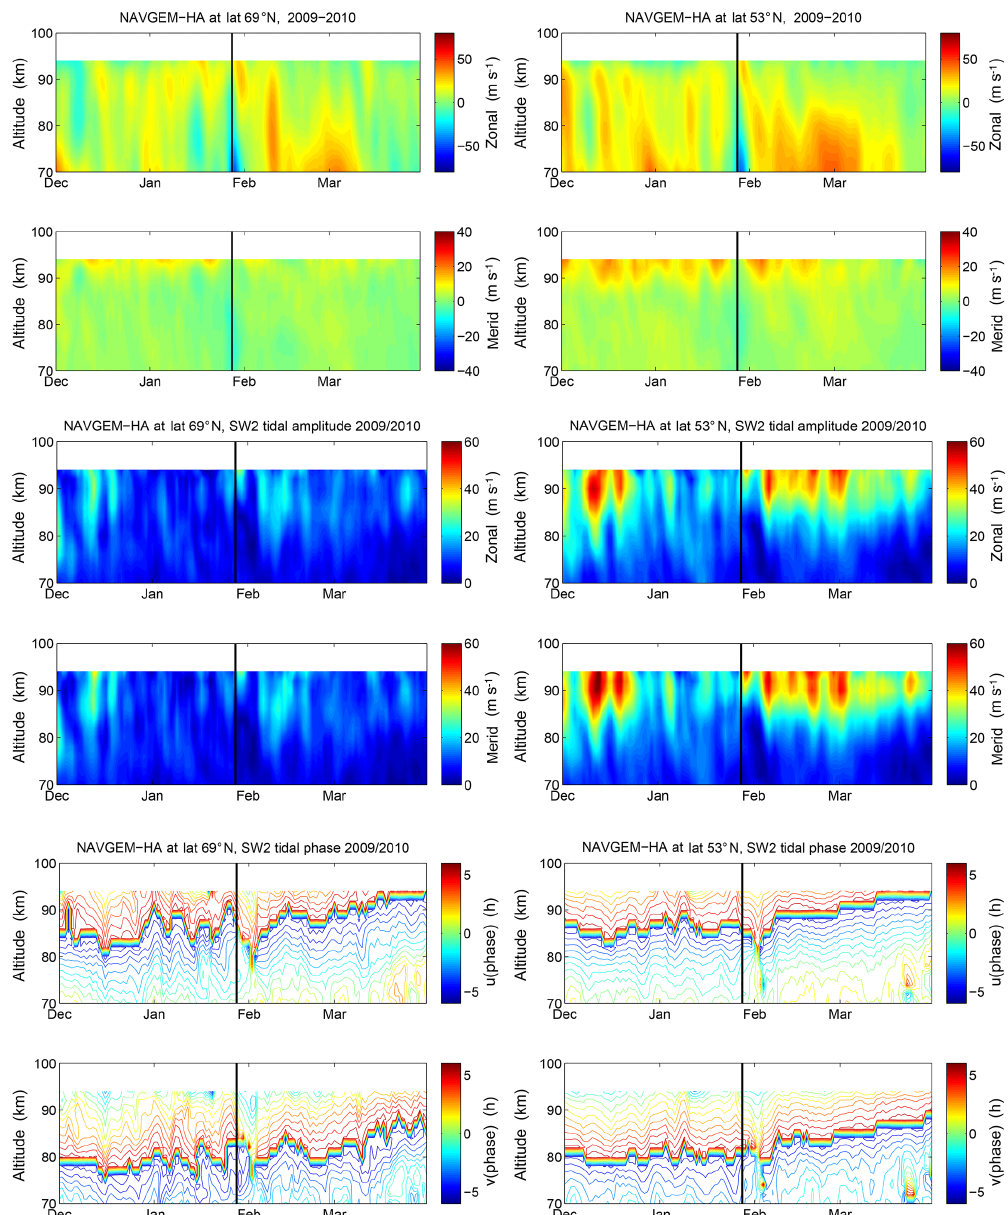
Figure 8. Comparison of global NAVGEM-HA above Andenes and Juliusruh during the winter of 2009/10 for daily zonal mean zonal and meridional winds (two upper panels), zonal mean semidiurnal tidal zonal and meridional amplitude (middle panels) and zonal mean semidiurnal tidal phases (two lower